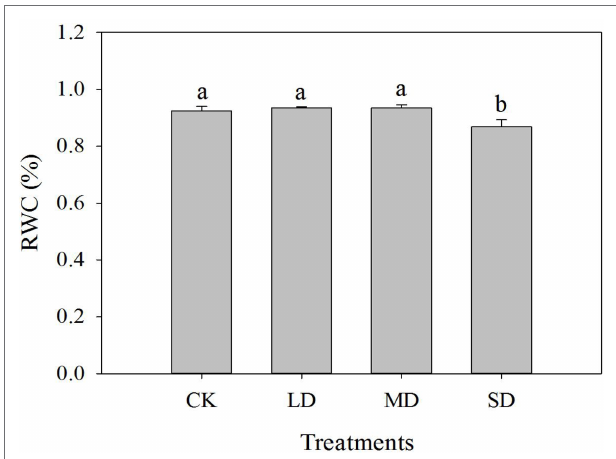
FIGURE 1 | Effects of drought stress on the relative water content (RWC) of Sophora davidii leaves. The different lowercase letters indicate significant differences ( p < 0.05) for each index among the different drought